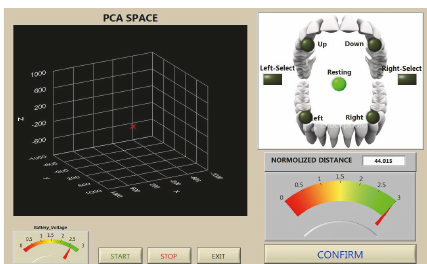
Figure 2: Pretraining calibration. Pretraining graphical user inter- face (GUI) showing the virtual 3D representation of the magnetic tracer, attached to the user’s tongue, in the oral space. Principal component analysis (PCA) space comprised transformed vectors, identifying unique tongue positions in 3D space.